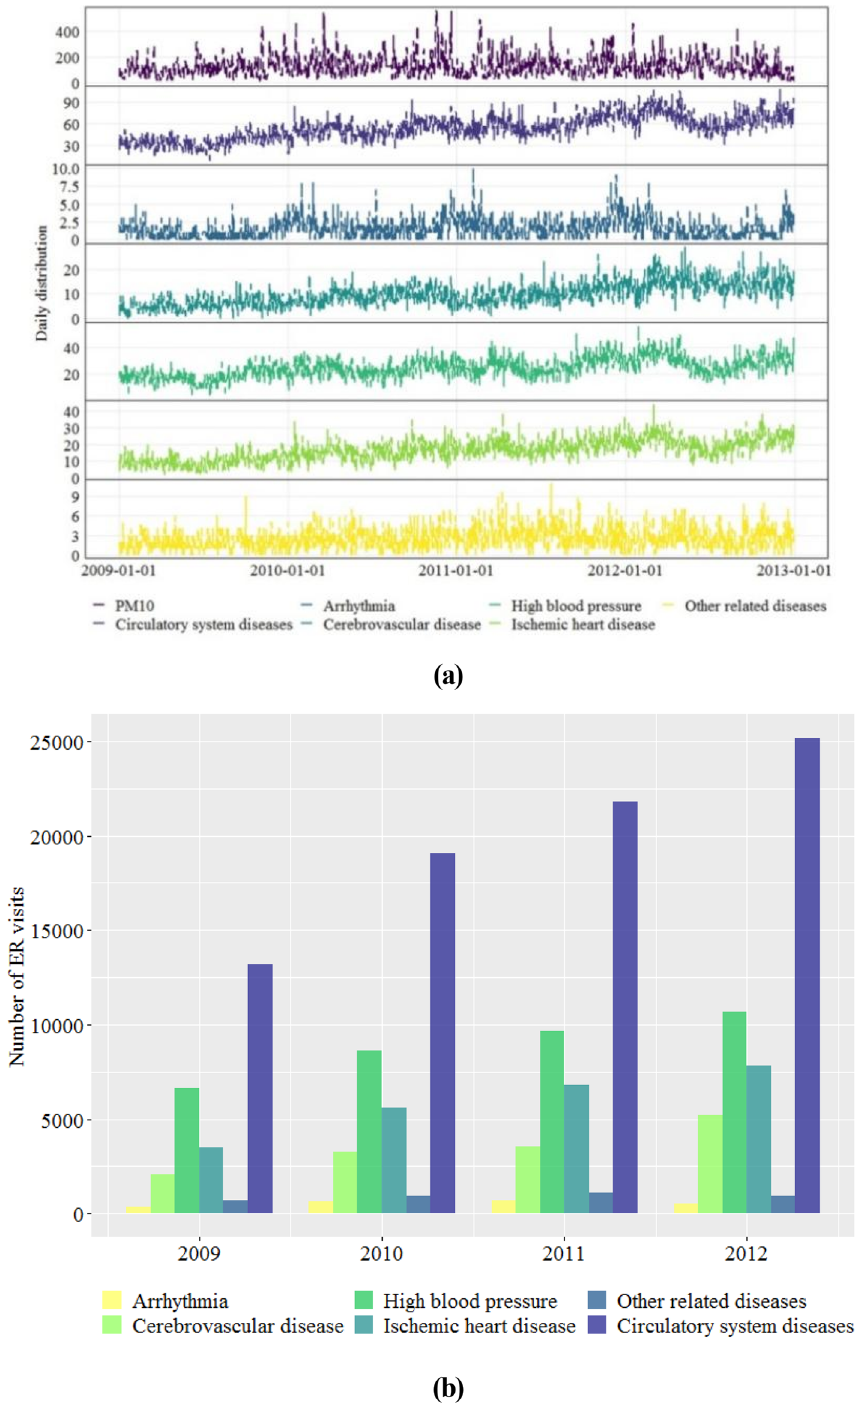
Figure 2. Time series of (a) PM 10 and (b) emergency room visits for circulatory system diseases in Beijing, Figure 2 describes the time series of PM 10 and CSDs ER visits during the study period. The concentration of PM 10 increased in 2009–2010 and then declined slightly, but remained at a high concentration level. The number of ER visits for CSDs increased year by year and this trend was also found in visits due to cerebrovas- cular disease, high blood pressure, and ischemic heart disease. The number of ER visits for arrhythmia and other related diseases increased from 2009 to 2011, but declined slightly in 2012. Among the aforementioned diseases, high blood pressure was the top reason for ER visits (accounted for 44.92% of the total ER visits for